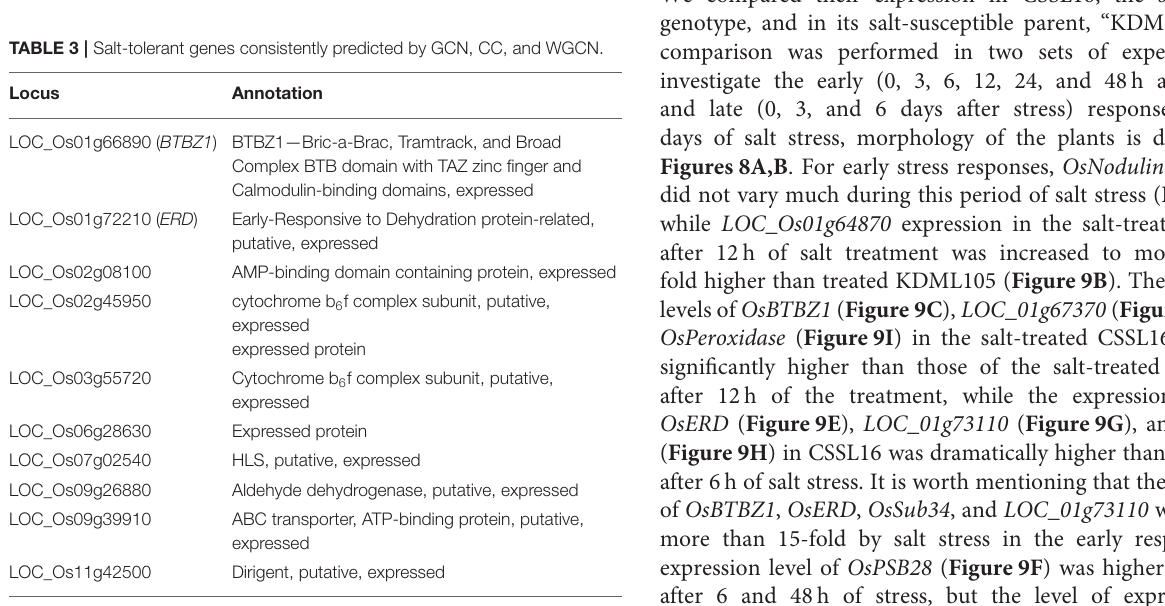
FIGURE 6 | Venn diagram (A) showing the number of salt-responsive genes from co-expression network analysis (blue circle), Clustering coefficient analysis (red circle), weighted co-expression network analysis (green circle), and Venn diagram (B) showing number of salt-responsive genes containing the SNPs in each method analysis.